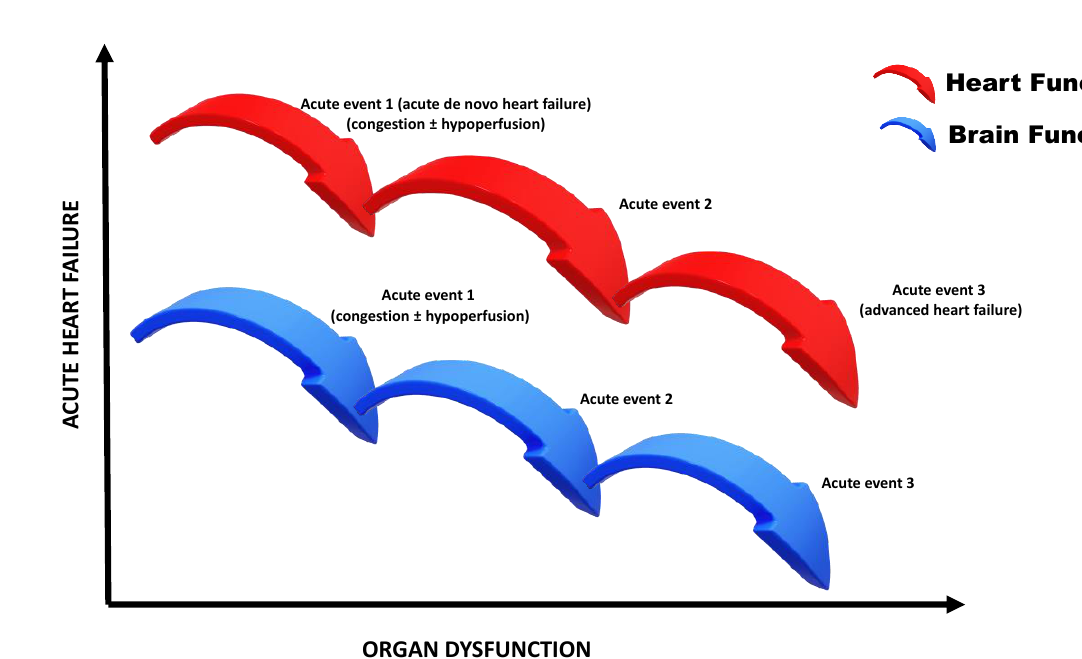
Figure 1. Progression of brain injury during the natural course of acutely decompensated heart failure.